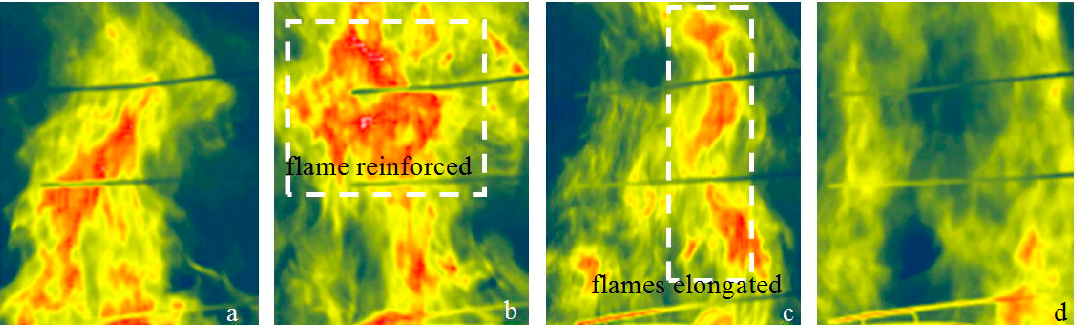
Figure 6. Flame structural changes during combustion: ( a ) normal combustion flame, ( b – d ) changing flame characteristics after water mist.